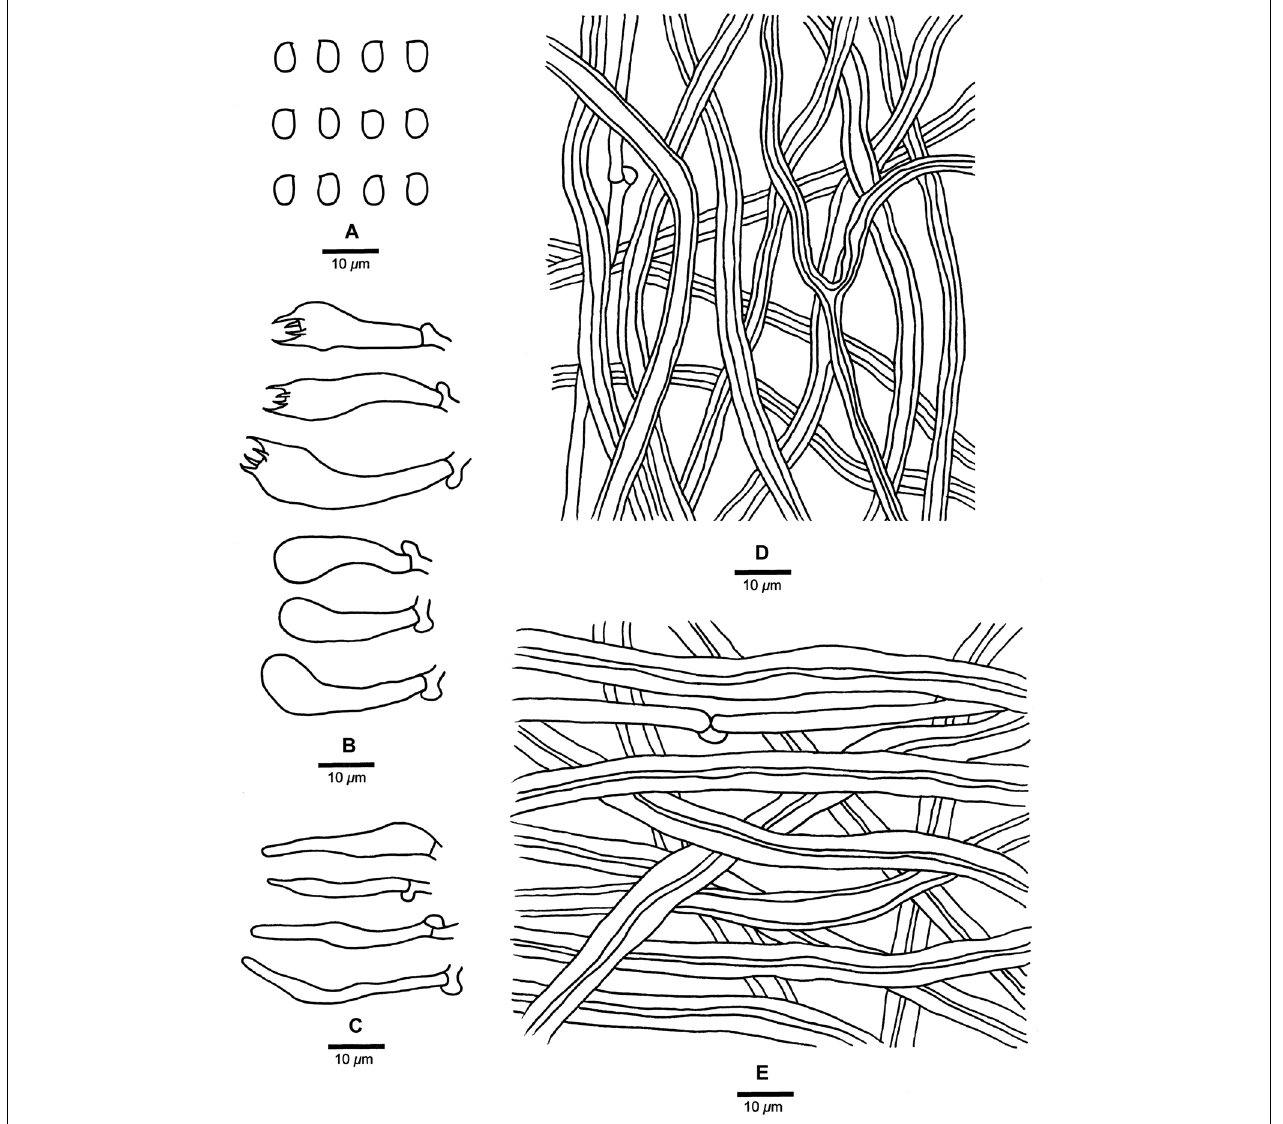
FIGURE 5 | Microscopic structures of Fomitopsis hengduanensis (drawn from the holotype). (A) Basidiospores; (B) Basidia and basidioles; (C) Cystidioles; (D) Hyphae from trama; (E) Hyphae from context. Bars: A–E = 10 µ m.